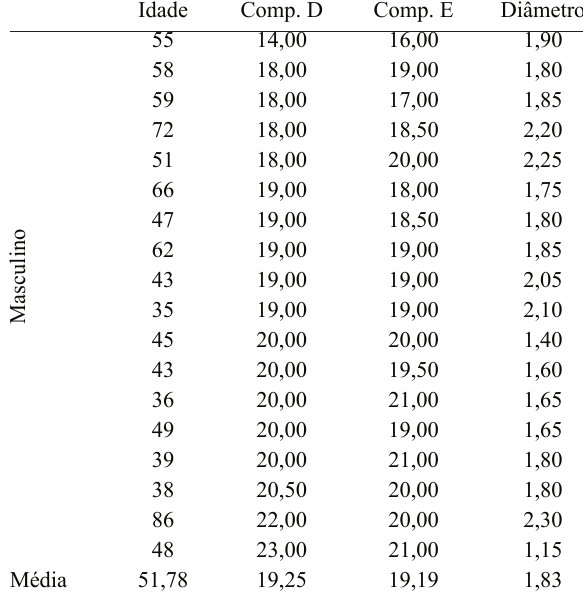
Fig. 4 - Microscopia das artérias. Artéria radial com depósito de gordura em seu endotélio, com infiltração até a camada muscular - Coloração